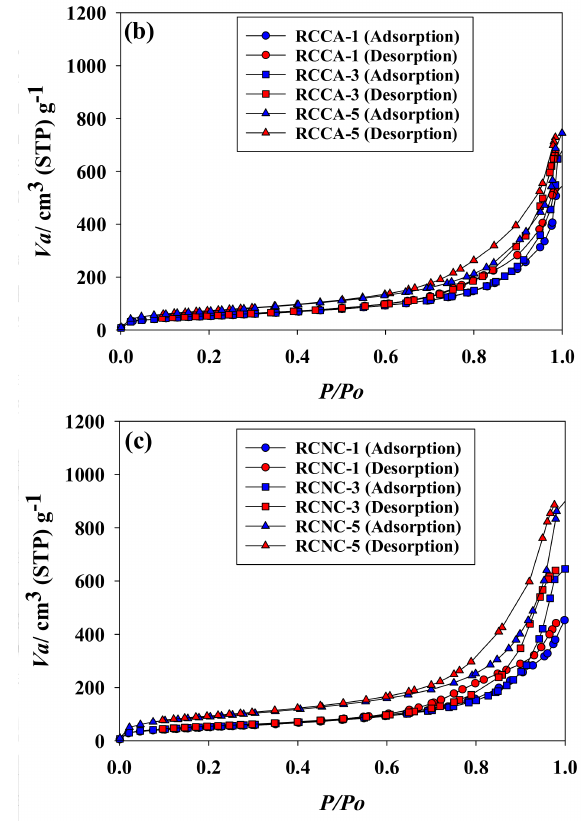
Figure 1. Nitrogen gas adsorption and desorption isotherms of ( a ) RC (regenerated cellulose) and the manufactured composites ( b ) RCCA-(1, 3, and 5), and ( c ) RCCA-(1, 3, and 5).